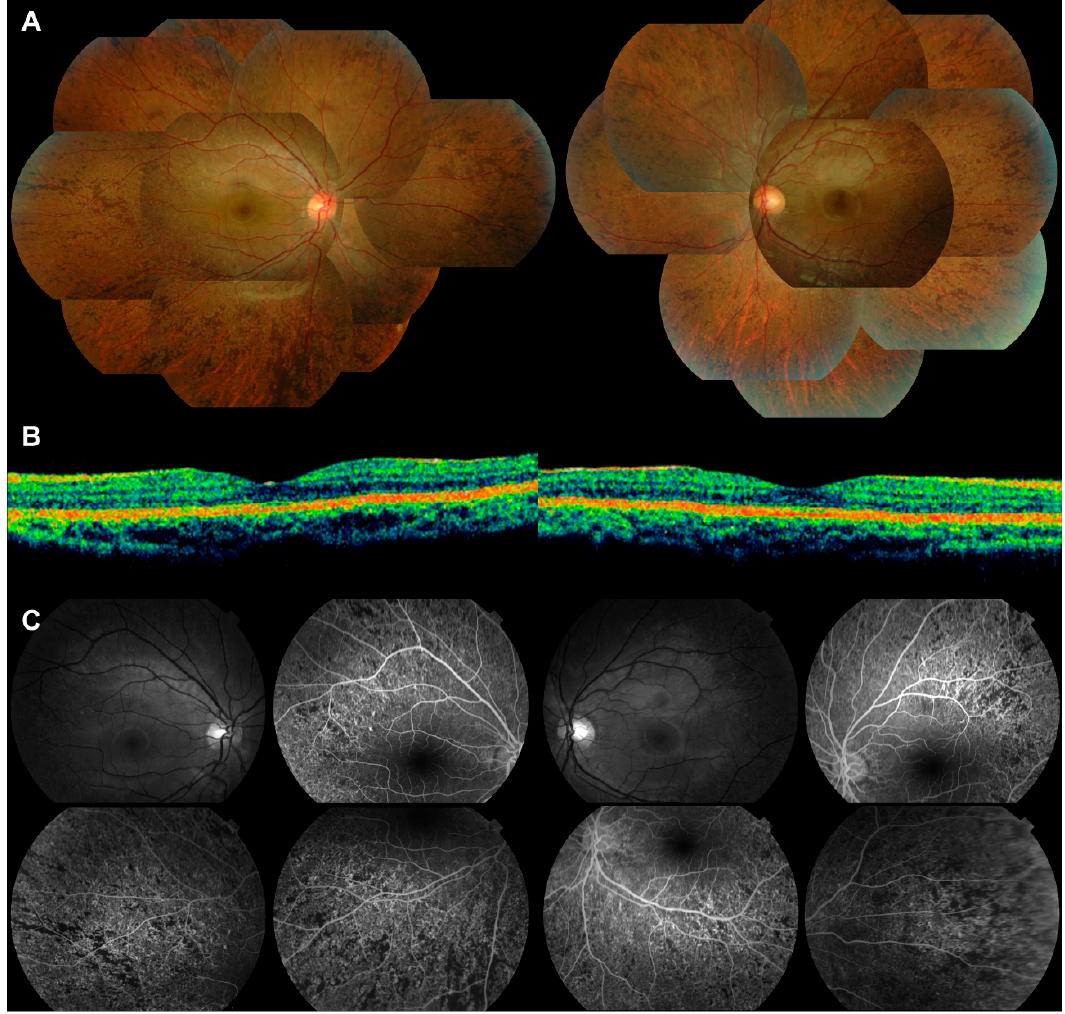
Figure 1. Peripheral retinopathy associated with Danon disease in a female Asian patient. ( A ) Images taken at initial presentation (21 years old). Mosaic fundus photographs of both eyes show peripheral pigmentary retinopathy with a diffuse salt-and-pepper pattern of lesions (top); ( B ) optical coherence tomography (OCT) images of the macula reveal no abnormalities (bottom); ( C ) fluorescein angiography images of both eyes show diffuse retinal pigment epithelial atrophy confined to the peripheral retina.